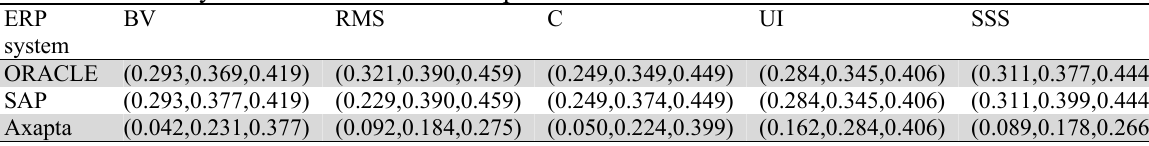
Normalized Fuzzy decision matrix for example 2